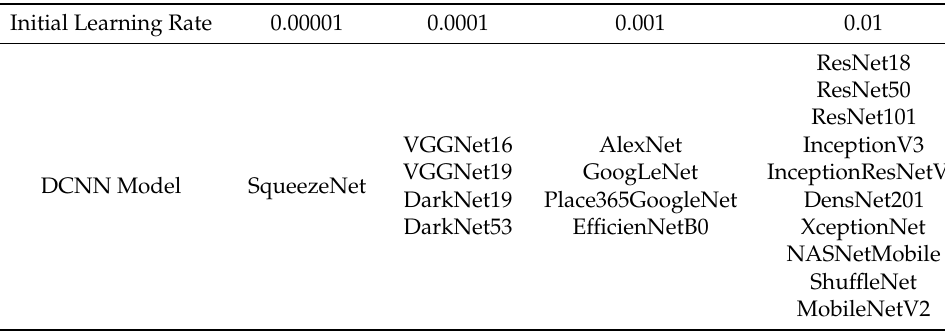
Table 5. The initial learning rate of each